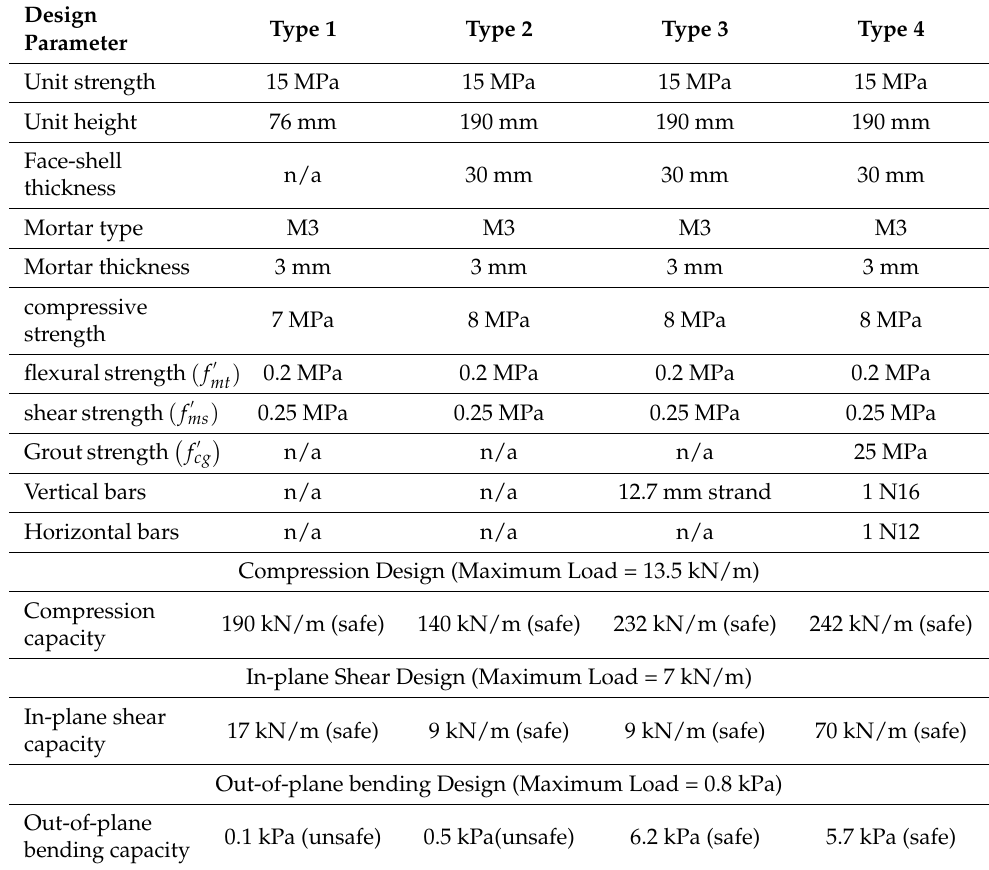
Table 3. Design details of critical walls for different masonry